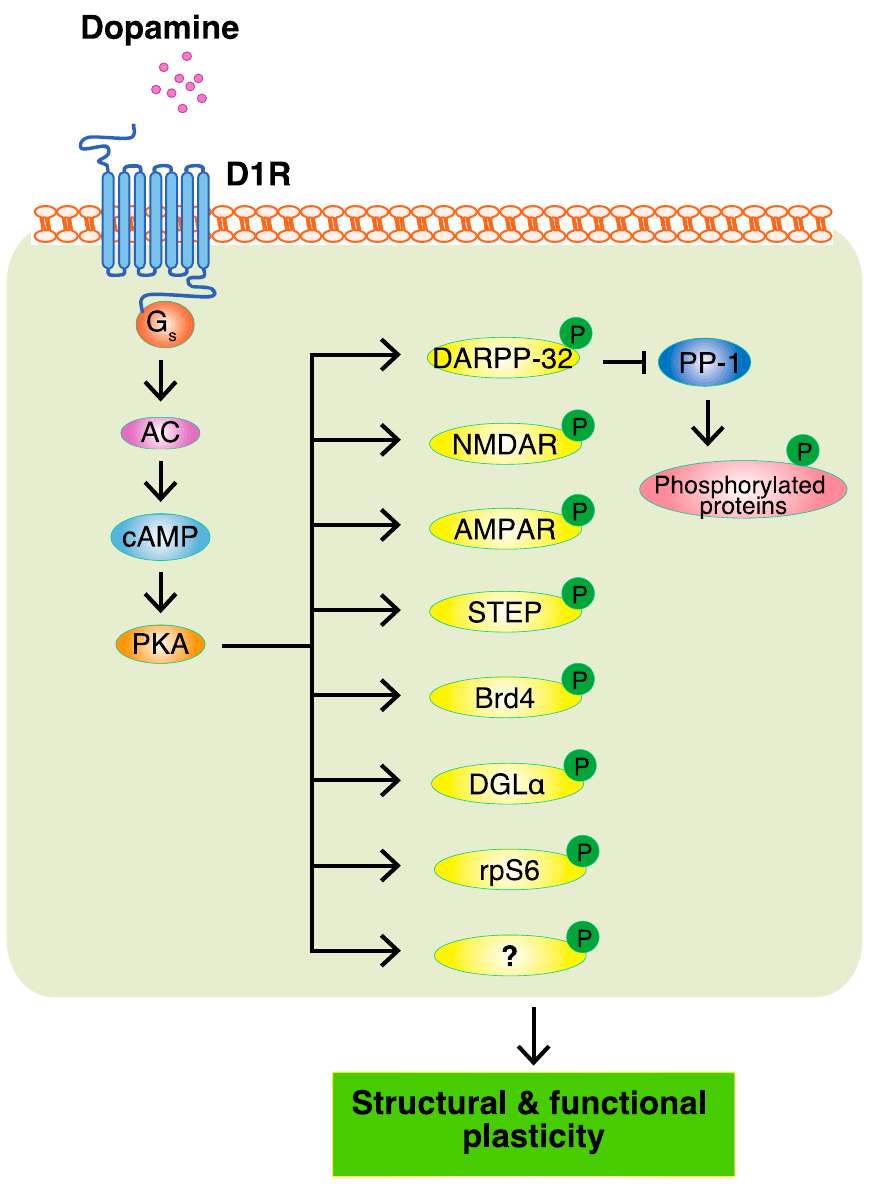
Figure 2. The PKA-dependent phosphorylation of receptors, ion channels, transcription factors, and other proteins accounts for structural and functional plasticity regulated by dopamine. D1R, dopamine D1 receptor; Gs, stimulatory G protein; AC, adenylate cyclase; cAMP, cyclic adenosine monophosphate; PKA, protein kinase A; DARPP-32, dopamine- and cAMP-regulated phosphoprotein of 32 kDa; PP1, protein phosphatase-1; NMDAR, NMDA receptor; AMPAR, AMPA receptor; STEP, striatal-enriched protein tyrosine phosphatase; Brd4, bromodomain-containing protein 4; DGL α , diacylglycerol lipase- α ; rpS6, ribosomal protein S6. “?” indicates unknown PKA